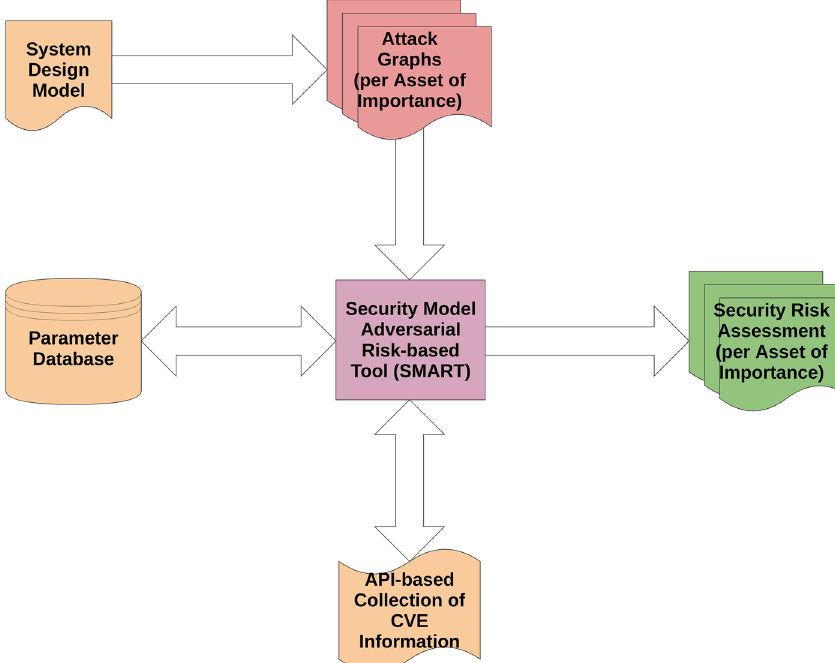
Fig. 8 Illustration of flow graph for